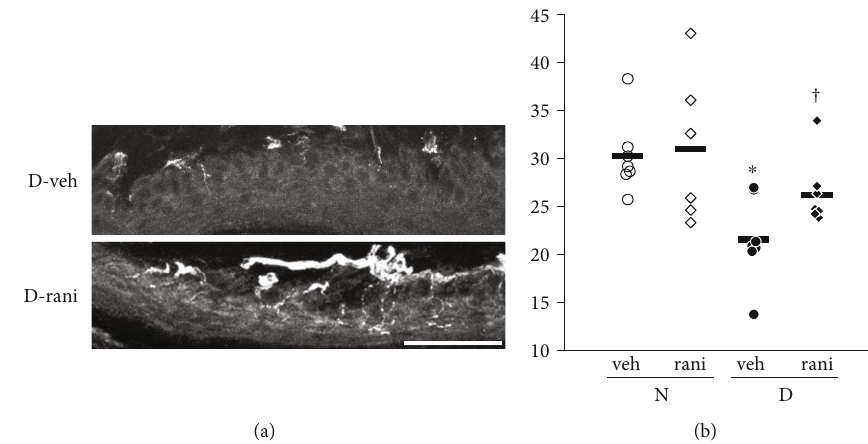
Figure 3: Intraepidermal nerve fi ber density (IENFD) after the treatment with ranirestat. (a) Representative photos of IENFs in diabetic rats treated with or without ranirestat. (b) Quanti fi cation of the IENFD revealed a signi fi cant decrease in untreated diabetic rats and the signi fi cant amelioration by ranirestat treatment. N: nondiabetic rats; D: diabetic rats; veh: rats treated with placebo; rani: rats treated with ranirestat. ∗ p < 0 : 05 versus N treated with placebo, † p < 0 : 05 versus D treated with ranirestat, and n = 6 – 8 in each group. Scale bar: 50 μ m.